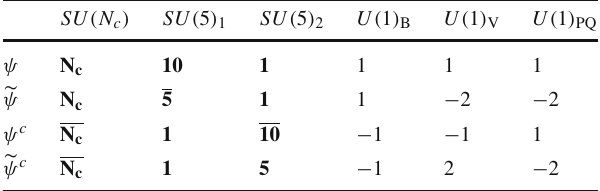
Table 1 Axion constituents, and their accidental U ( 1 ) symmetries, in our